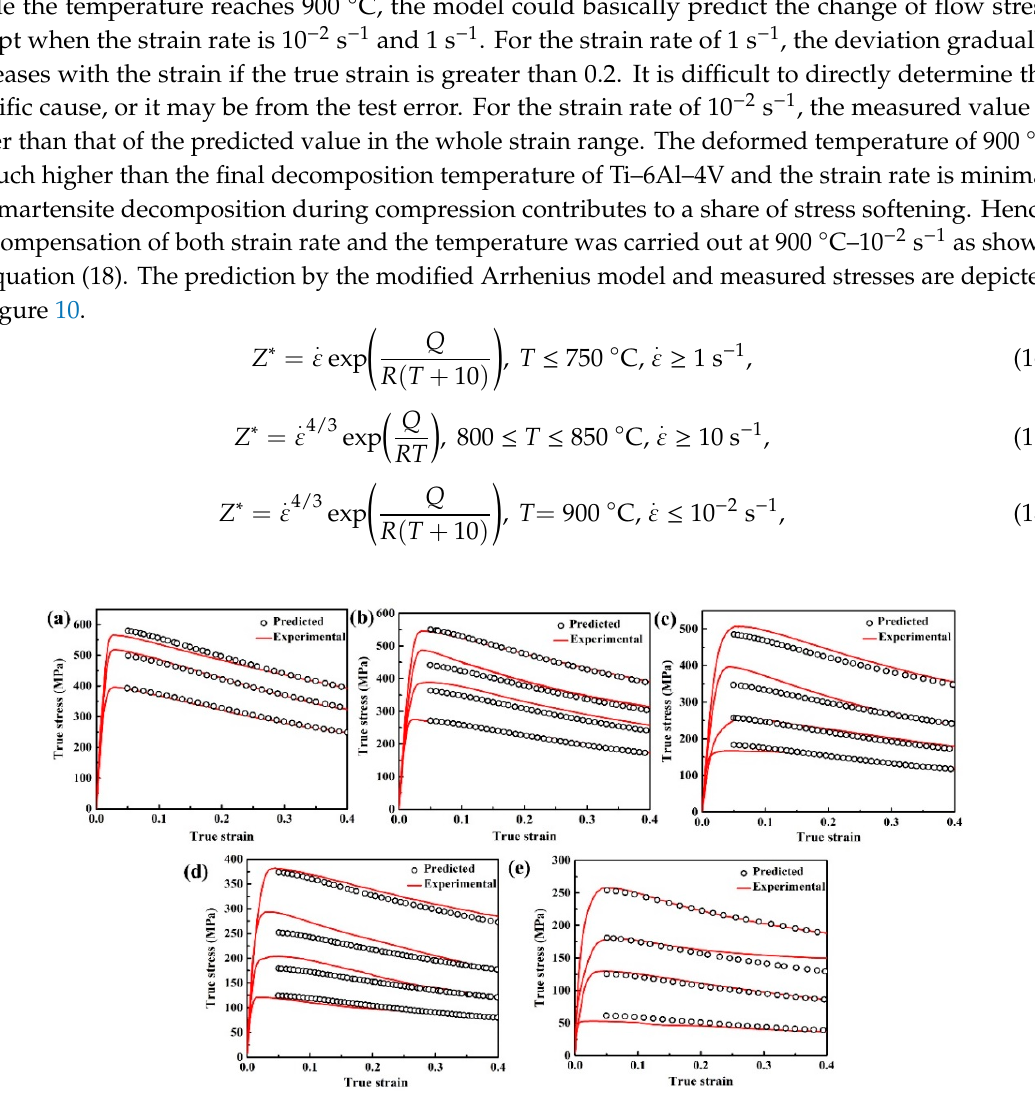
Figure 10. Comparison between the predicted stresses by the modified Arrhenius model and the experimental ones: ( a ) 700 °C, ( b ) 750 °C, ( c ) 800 °C, ( d ) 850 °C, and ( e ) 900 °C.